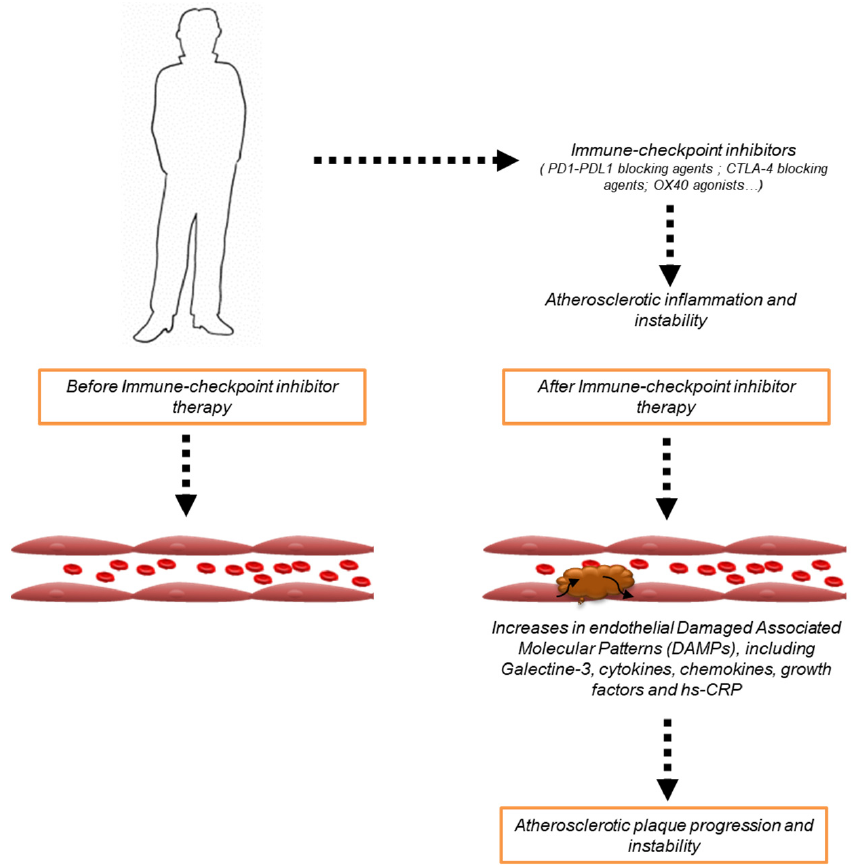
Figure 1. Cancer patients treated with ICIs therapies (i.e., PD ‐ 1 or PDL ‐ 1 or CTLA ‐ 4 blocking agents or OX40 agonists) increases endothelial DAMPs, including Galectine ‐ 3, cytokines, chemokines, growth factors, and hs ‐ CRP that are associated with plaque progression and instability.